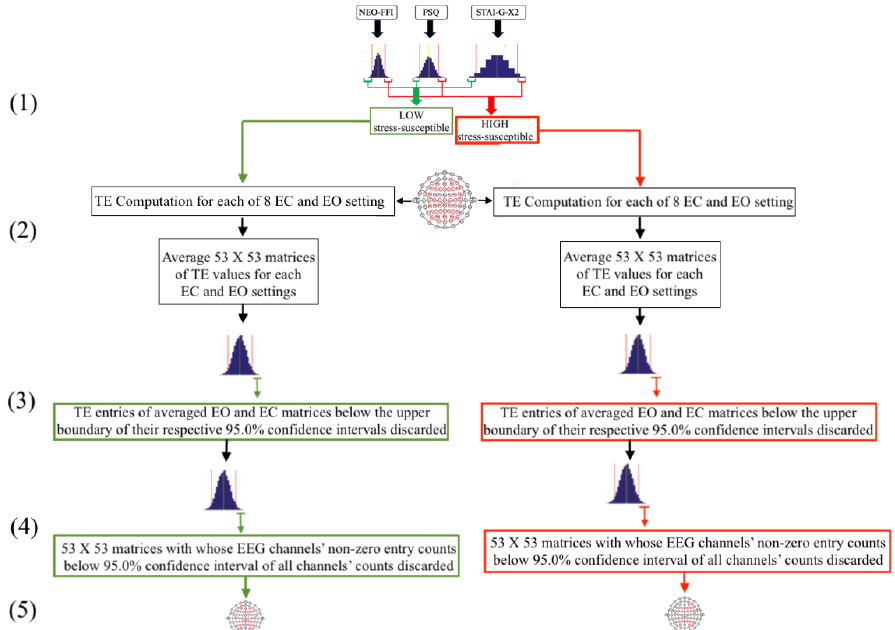
Figure 2. An overview of data inclusion in the present study. The procedure comprised five steps. (1) 95.0% confidence intervals of participants’ responses to each of NEO-FFI, PSQ, and STAI-G-X2 were calculated separately. Subsequently, participants whose responses to each of three questionnaires fell in lower/upper boundary of respective confidence interval of its related questionnaire (indicated by green/red lines, respectively) were placed in LOW/HIGH stress-susceptible groups. (2) Pair-wise TE values for all available 53-EEG-channels (Figure 1B) for each of these LOW and HIGH stress-susceptible participants, per individual, for each of their EC and EO settings’ matrices (i.e., 8 matrices, per setting) were calculated. This resulted in 8 TE matrices of size 53 × 53, per EC and EO settings. This was followed by averaging 8 TE matrices for each of EC and EO settings, per participant, thereby obtaining one averaged 53 × 53 TE matrix, per EC and EO settings, per participant. (3) 95.0% confidence interval for TE values, per EC and EO settings, of all participants in LOW and HIGH stress-susceptible groups were separately computed (i.e., 10 × 53 × 53 = 28090 TE values, per EC and EO settings) and TE values, per participant, per setting, that were below the upper boundary of their respective group’s confidence interval (i.e., per EC and EO settings) were discarded. (4) 95.0% confidence intervals for combined individuals’ number of non-zero entries in each row of the averaged TE matrices, per EC and EO settings, per stress-susceptible group, were computed and EEG channels whose number of non-zero TE entries were below the upper boundary of their related confidence interval were discarded, per individual, per stress-susceptible groups, and per EC and EO settings. (5) Union of EEG channels among individuals in each of LOW and HIGH stress-susceptible groups, per EC and EO settings, were separately selected (i.e., two EEG channels’ arrangements at the bottom, Figure A2). In the case of EC, we found 18 EEG channels that survived these thresholding steps and that were common between all participants in HIGH stress-susceptible group (AFZ, AF4, F1, F6, FT7, CZ, C2, C6, CP5, CP3, CP1, CP4, P7, P5, P4, P6, PO3, POZ). We also found 18 surviving EEG channels that were common among all participants in LOW stress-susceptible group (FP2, AFZ, F3, F5, FZ, CP1, CP3, CP5, CPZ, P7, P3, P4, P2, P6, PO3, POZ, PO4, O2). We used the union (without repetition) of these EEG channels for comparative analyses between HIGH and LOW stress-susceptible groups during EC setting (Figure A2A). In the case of EO, we found 21 EEG channels that survived these thresholding steps and that were common between all participants in HIGH stress-susceptible group (AF3, AF4, C1, C2, C6, CP3, CP4, CP5, F1, F2, F6, FC5, FC6, FT7, FT8, Fp2, Fz, O1, P1, P6, PO4). The number of such EEG channels in LOW stress-susceptible group was 17 (AF3, AF8, AFZ, C2, CP3, CPZ, F2, F4, FC5, FC6, FT7, Fp2, Fz, P2, PO7, PO8, PZ). Similar to the case of EC, we used the union of these EEG channels for comparative analyses between HIGH and LOW stress-susceptible groups for EO setting (Figure